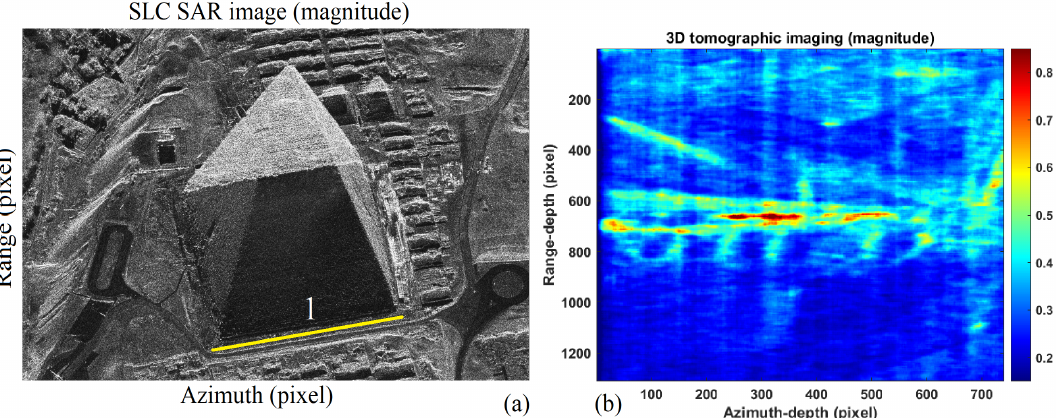
Figure 33. SAR images. ( a ): SLC SAR image (magnitude). The tomographic line 1 is oriented along the Western-side of the pyramid. ( b ): Tomographic result (magnitude).